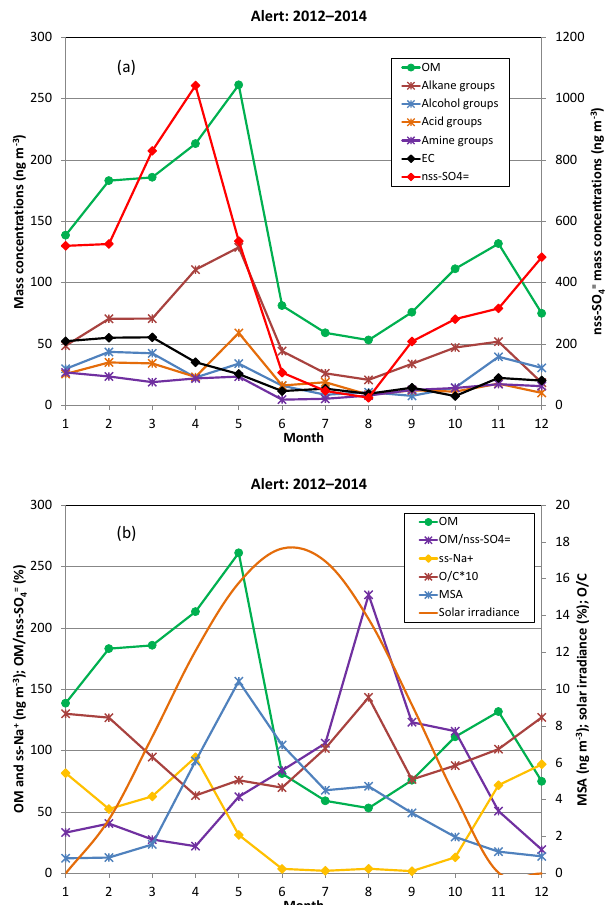
Figure 5. Monthly averages showing the annual variations of (a) OM, functional group concentrations, EC and nss-SO = , and 4 (b) OM, OM / nss-SO = , ss-Na + , O / C (multiplied by 10) and 4 MSA. Also shown in panel (b) is the annual pattern of solar irra- diance as a percentage of the total irradiance across a year.